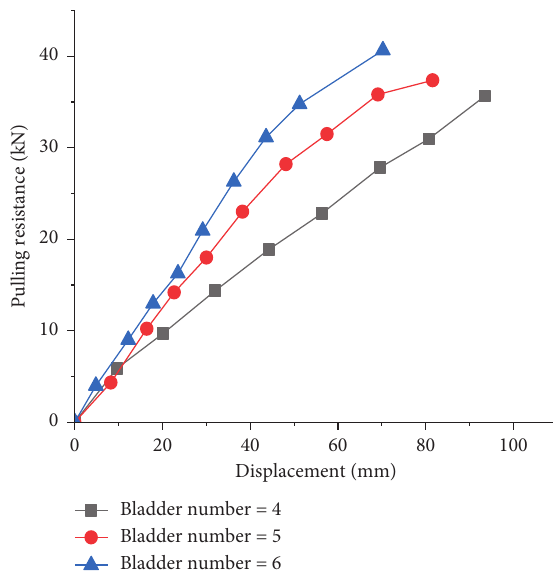
Figure 8: The pulling force vs. displacement relationship under different bladder number conditions.